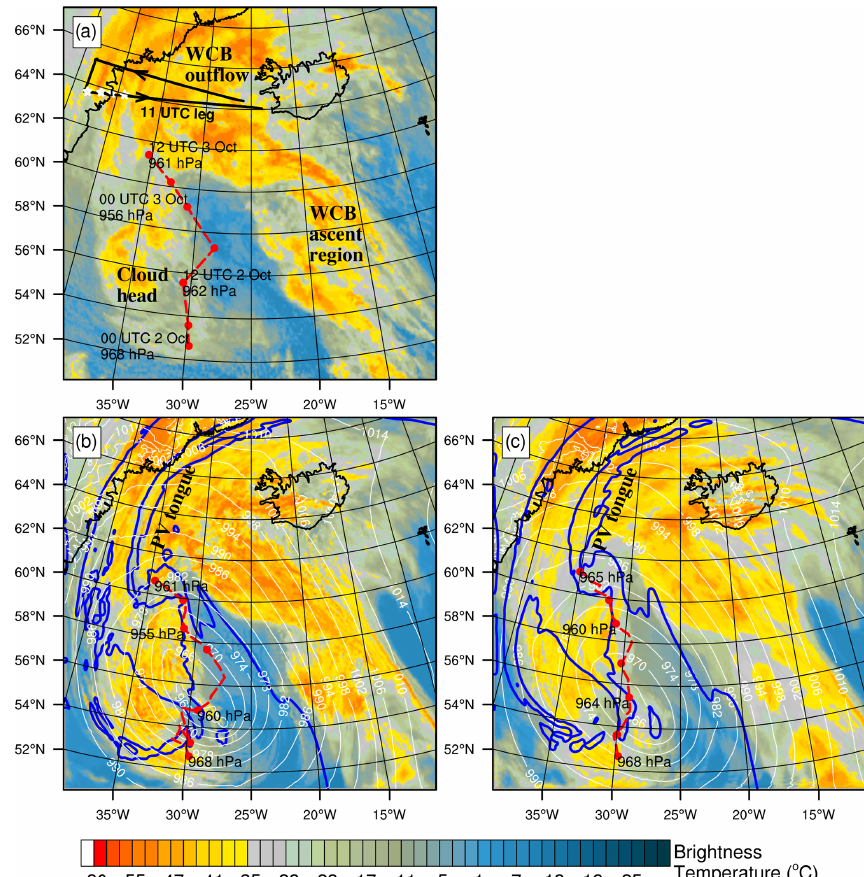
Figure 1. The 10.8µm brightness temperature (in ◦ C) at 11:00UTC, 2 October 2016, as (a) observed by the Meteosat Second Genera- tion (MSG) satellite and simulated by (b) REF (reference simulation) and (c) NODIA (sensitivity simulation). In (b) and (c) , mean sea level pressure (MSLP) is shown with white contours every 4hPa between 964 and 1016hPa, and the smoothed 2PVU at 320K is shown with blue contours. In (a) – (c) , the cyclone track and value of the MSLP minimum are shown (red dotted line; red mark every 6h) for the ECMWF (European Centre for Medium-Range Weather Forecasts) analysis and the REF and NODIA simulations. The MSLP minimum is tracked every 6h within a radius of 250km from its prior position in the ECMWF analysis and every 1h within a radius of 160km in the simulations. In (a) , the black line shows the track of the Falcon 20 aircraft and the 11:00UTC leg, whereas the white stars show the location of the dropsondes shown in Fig.